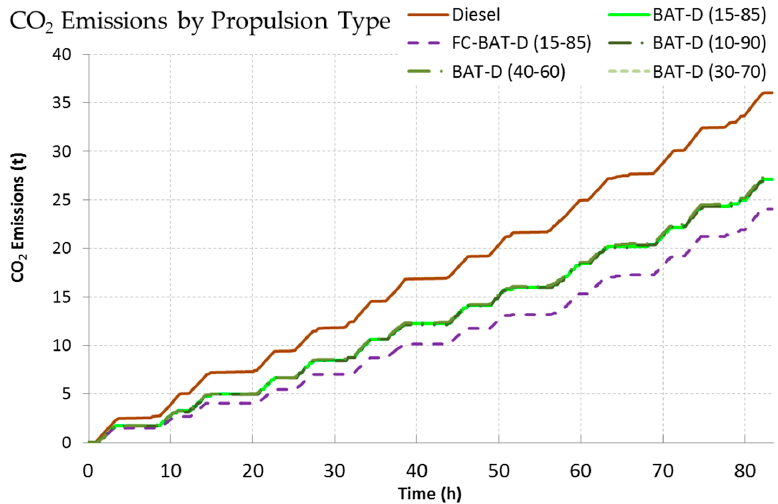
Figure 24. CO 2 emission depending on the selected drivetrain configuration: DIESEL, BAT-D (15–85), BAT-D (10–90), BAT-D (30–70), BAT-D (40–60), FC-BAT-D (15–85).